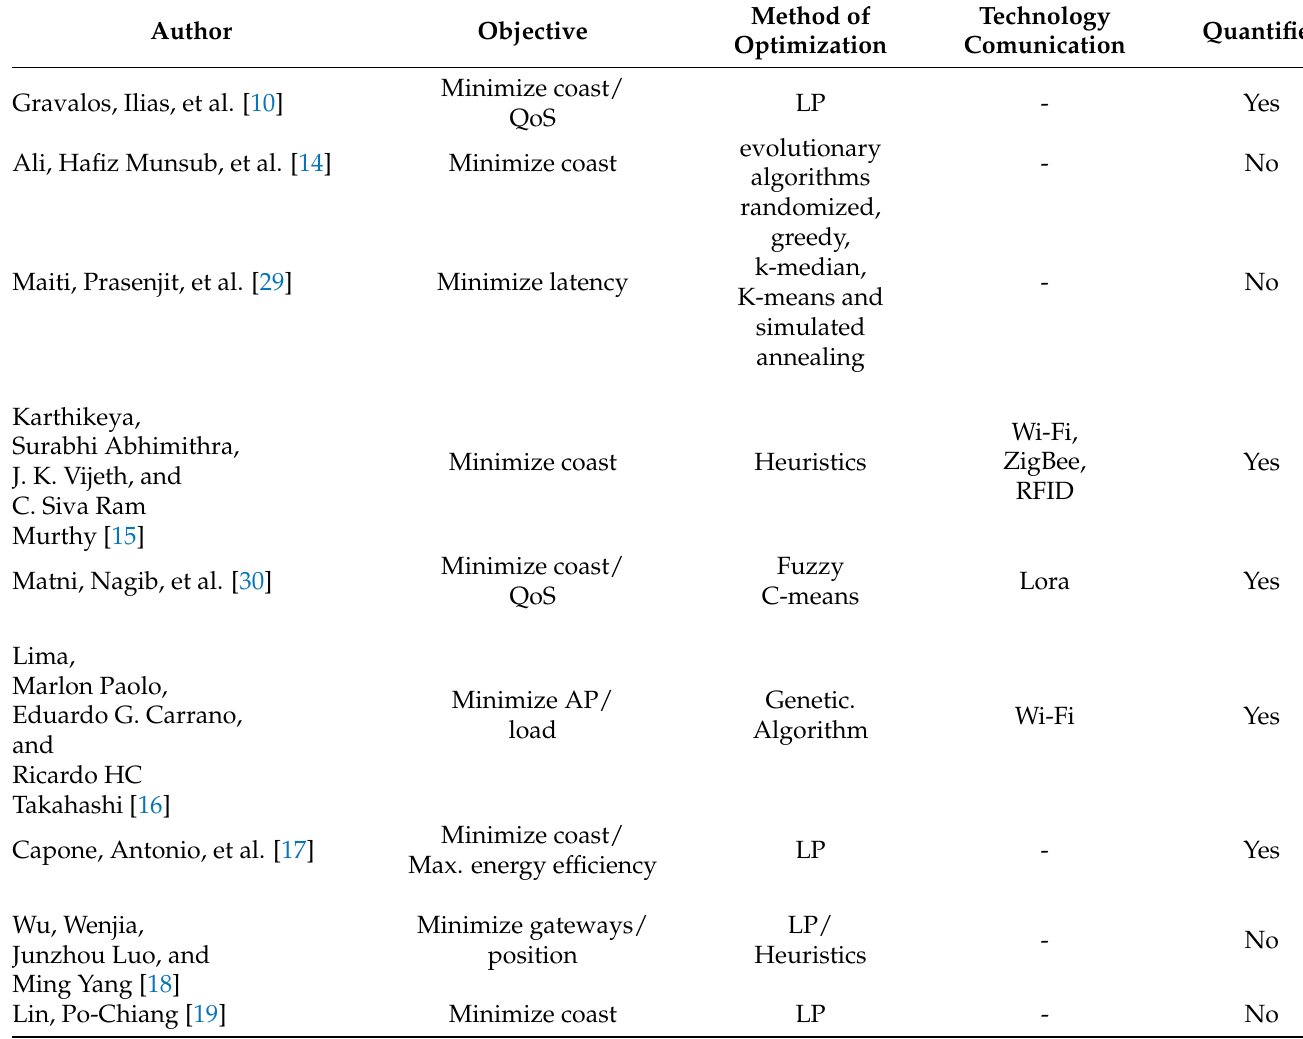
Table 2. Comparison of network planning related